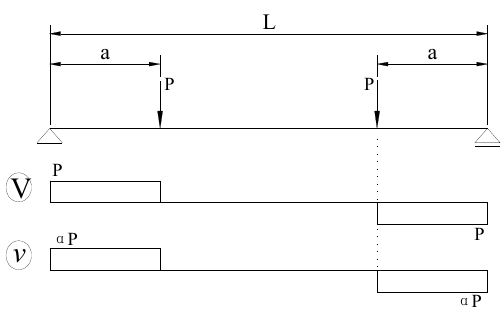
Figure 8. Distribution of the cross-sectional shear force and shear flow at the interface along the beam.